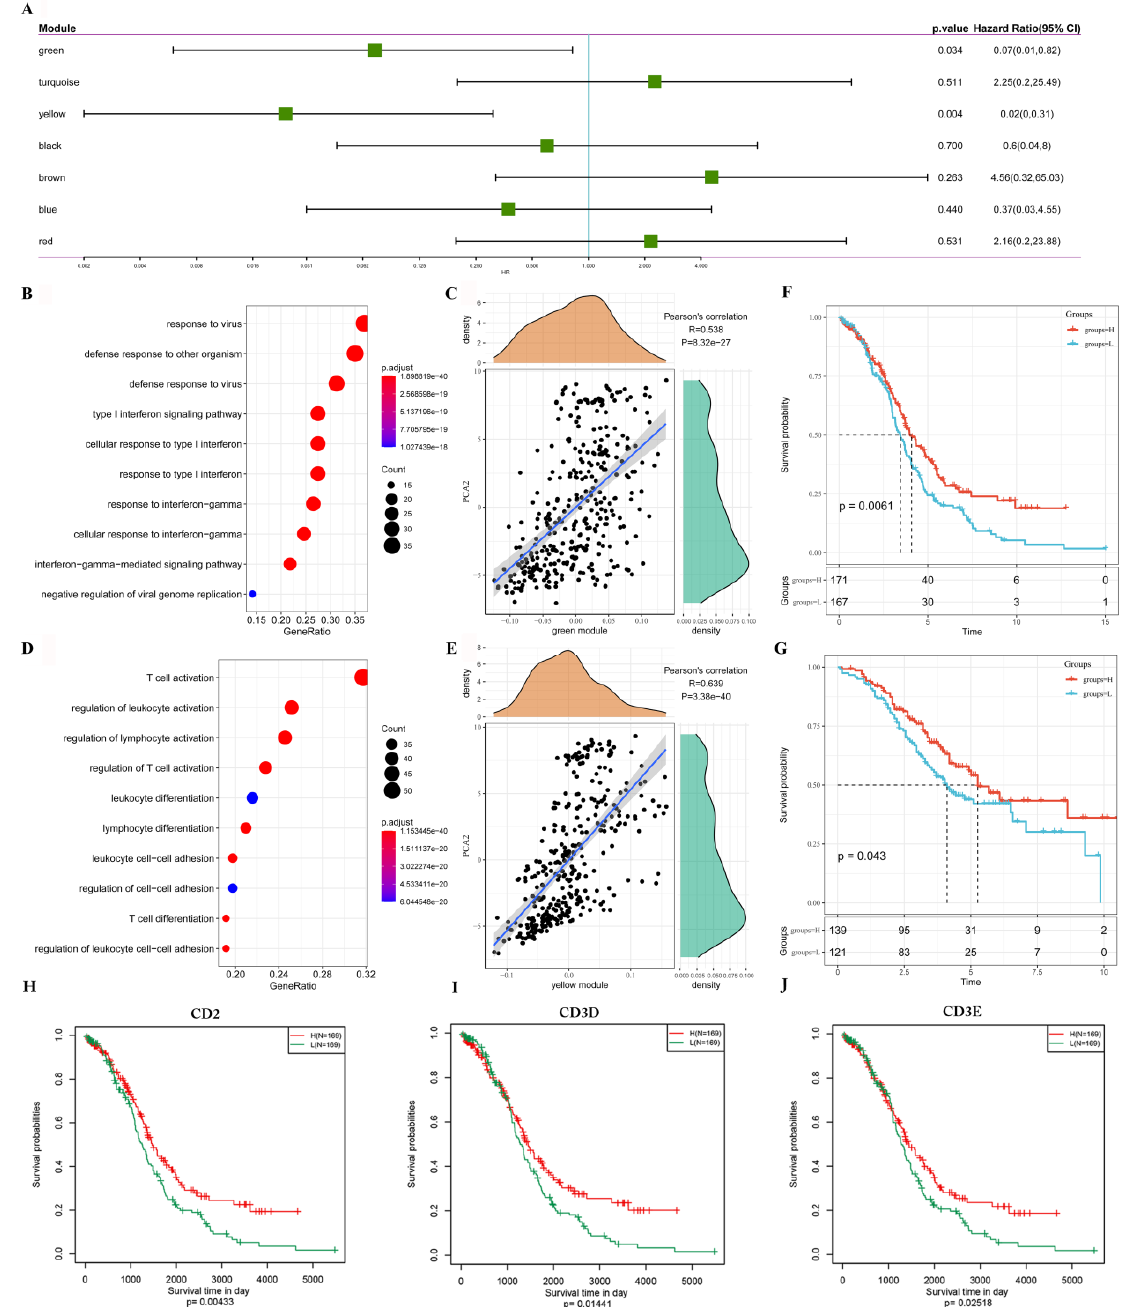
Figure 9. Identification of immune hub genes of OC. ( A ). Forest maps of single factor survival analysis of seven modules of OC. ( B ). Dot plot showing the top 10 KEGG terms in the green module. The dot color intensity and size represent the enrichment level and gene count respectively. ( C ). Correlation between the green module feature vector and the second principal component in the immune landscape. ( D ). Dot plot showing the top 10 KEGG terms in the yellow module. ( E ). Correlation between the yellow module feature vector and the second principal component in the immune landscape. ( F , G ). KM survival curve of patients grouped according to the expression of model characteristic genes in the yellow module in the TCGA cohort ( F ) and in the GSE32062 cohort ( G ). ( H – J ). KM survival curves of patients stratified by hub gene CD2 ( H ), CD3D ( I ), and CD3E ( J ) ex ‐ pression in the TCGA cohort.